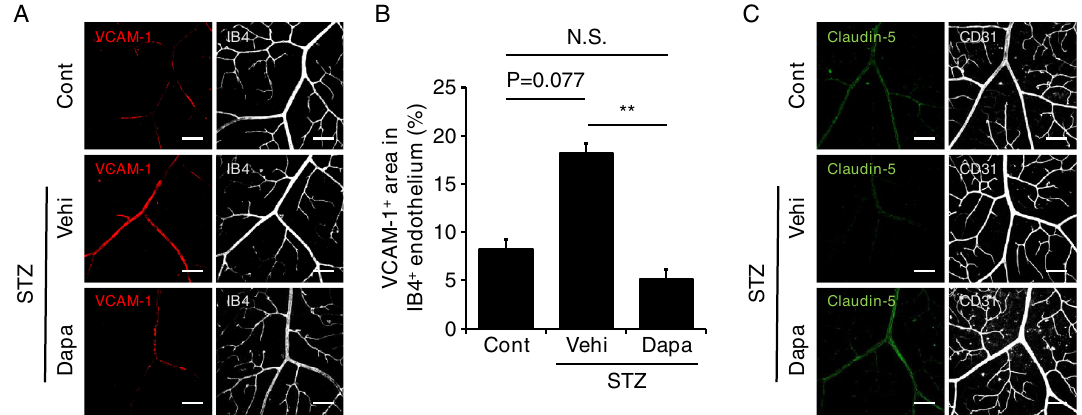
Figure 4. Glucose-lowering effects of dapagliflozin on vascular cellular adhesion molecule-1 and claudin-5 expression in the retinal vascular endothelium. After the onset of streptozotocin (STZ)-induced diabetes, 8-week-old male wild-type (WT) mice were treated with vehicle (STZ/Vehi) or dapagliflozin (STZ/Dapa) for 6 weeks. Mice without STZ injection were also analyzed as a control (Cont). Immunofluorescence staining was conducted using retinal whole-mount from each mouse. ( A ) Representative immunofluorescence images for vascular cellular adhesion molecule-1 (VCAM-1) (red) and isolectin B4 (IB4) (gray). Scale bar = 100 μm. ( B ) The % area of the VCAM-1-positive region in IB4-positive endothelium. Quantification was performed using two randomly obtained sections for each mouse. n = 4 for Cont, n = 7 for STZ/Vehi, and n = 6 for STZ/Dapa. Data are the mean ± SEM; **P < 0.01. N.S., not significant (one-way ANOVA with Tukey’s post hoc test). ( C ) Representative immunofluorescence images for claudin-5 (green) and CD31 (gray). Scale bar = 100